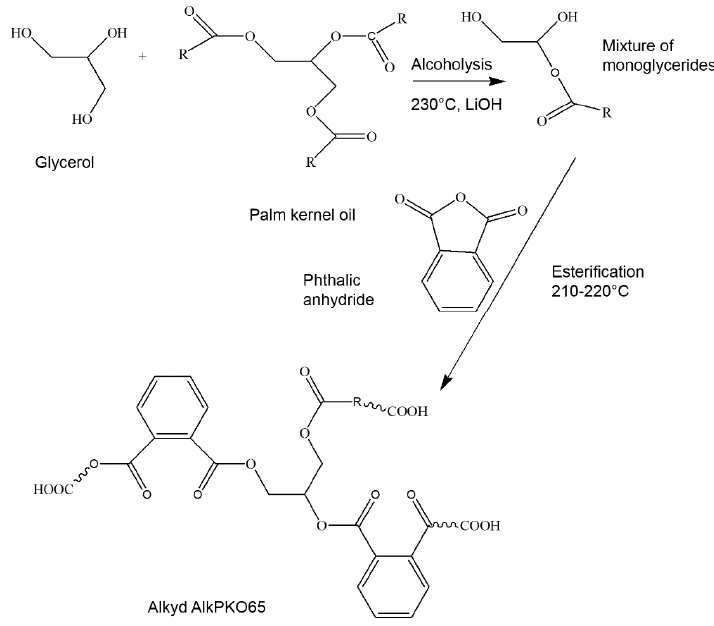
Figure 3. Plausible reaction in the formation of the alkyd.